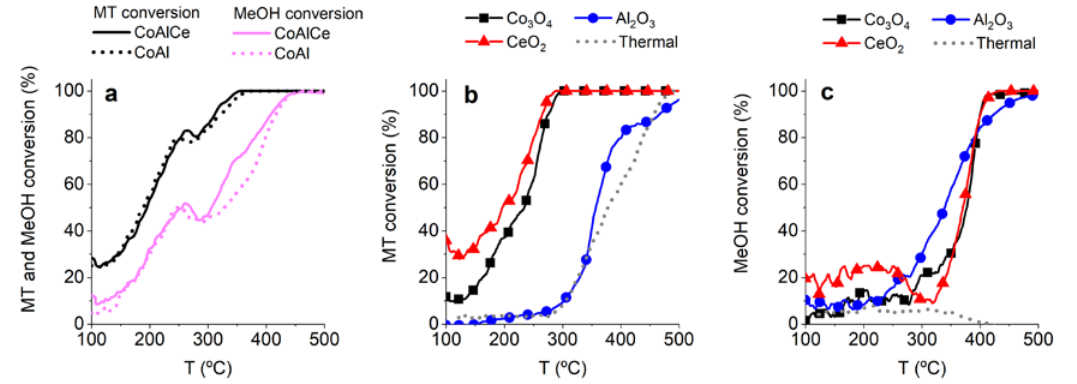
Figure 6. Methanethiol and methanol conversion vs. temperature over ( a ) mixed oxides and ( b , c ) over single oxides and in thermal oxidation.